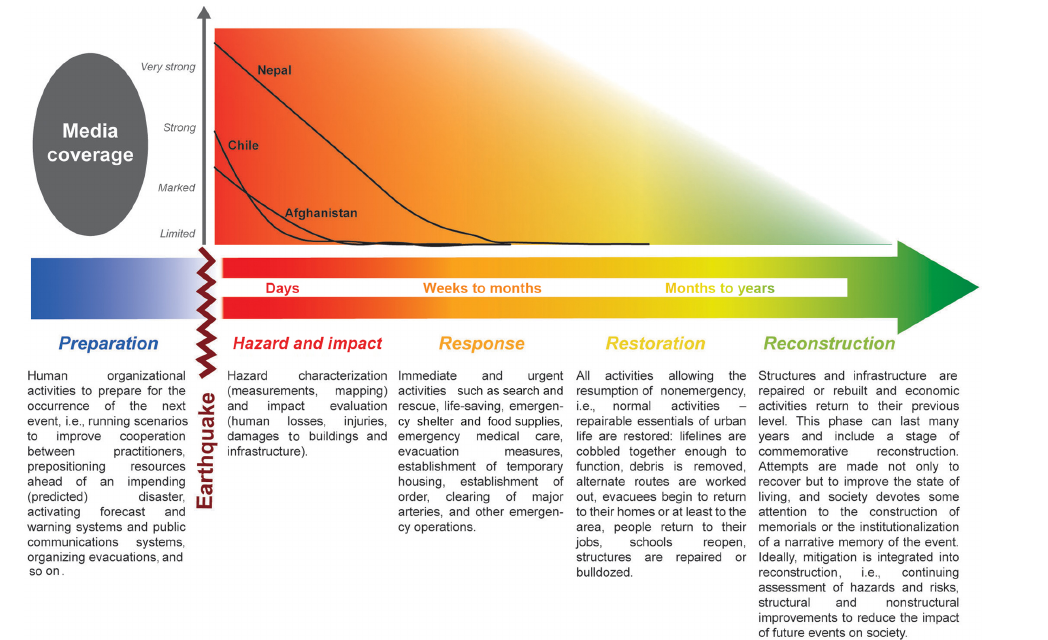
Figure 4. Temporal distribution of the media coverage for the three well-covered earthquakes of the year 2015. The color scale allows for comparison of the duration of the media coverage with the expected duration of the different phases of disaster risk management models.